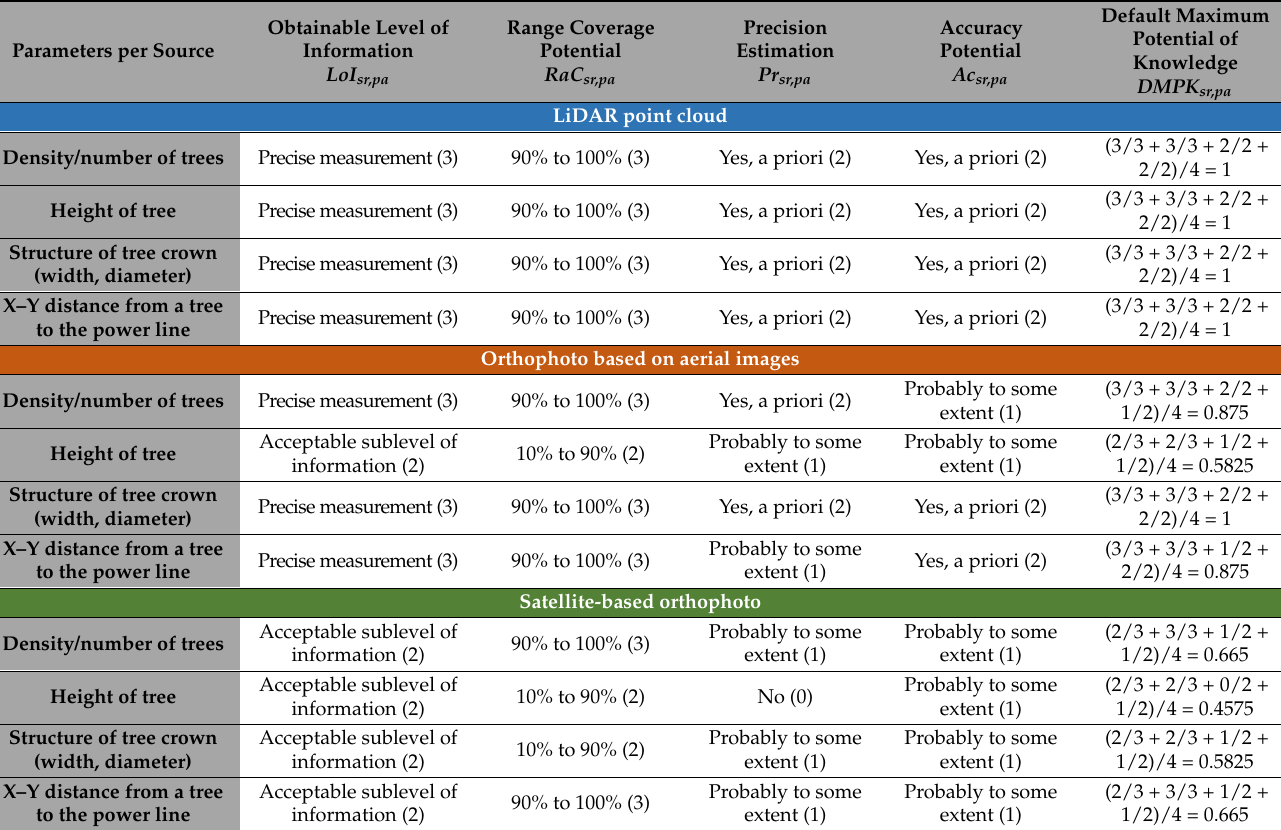
Table 20. Meta-features phase 1— DMPK calculation per data source per parameter.